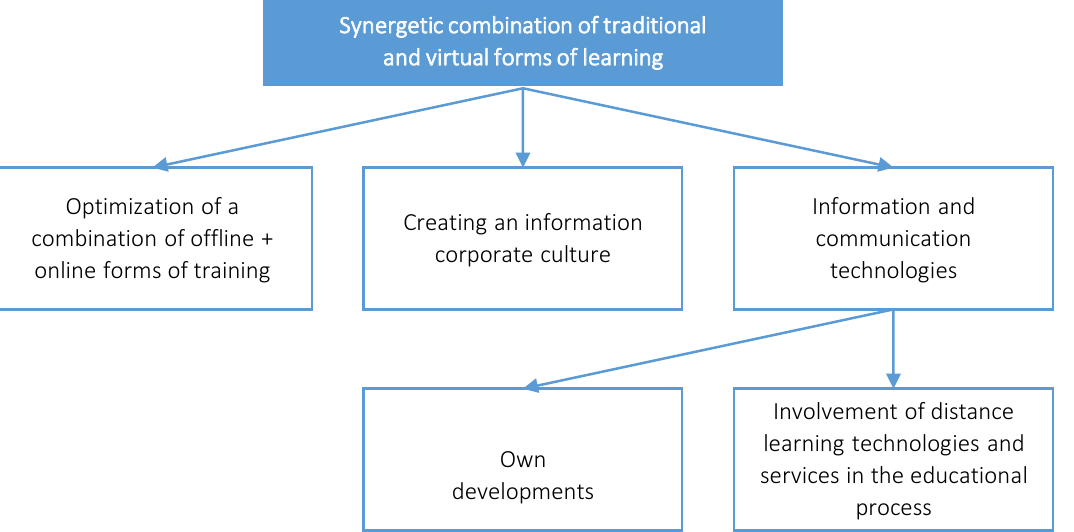
Figure 8. The scheme of combining traditional and virtual forms of